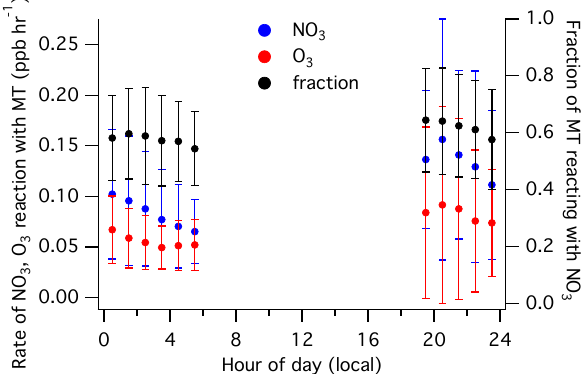
Fig. 10. Rates of reaction of NO 3 and O 3 with monoterpenes averaged for entire campaign, nighttime data only, using mea- sured [O 3 ] and [monoterpenes], and using the production rate of NO 3 ( k 1 [NO 2 ][O 3 ]) to stand in for the rate of NO 3 + MT, since it is assumed that every NO 3 produced reacts with MT. Right axis: the fraction of total MT reactivity due to reactions with NO 3 (black) suggests a greater role for NO 3 than O 3 as the initial oxidant in nighttime